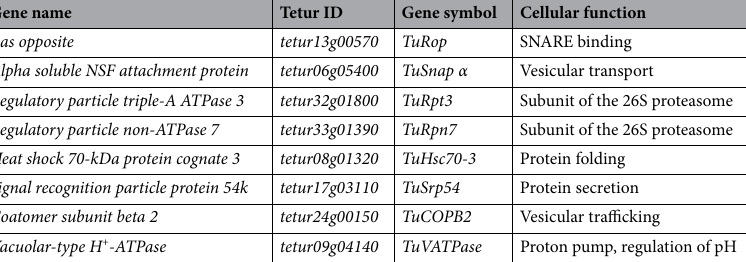
Table 1. List of Tetranychus urticae genes identified as highly efficient RNAi targets and used in this study.